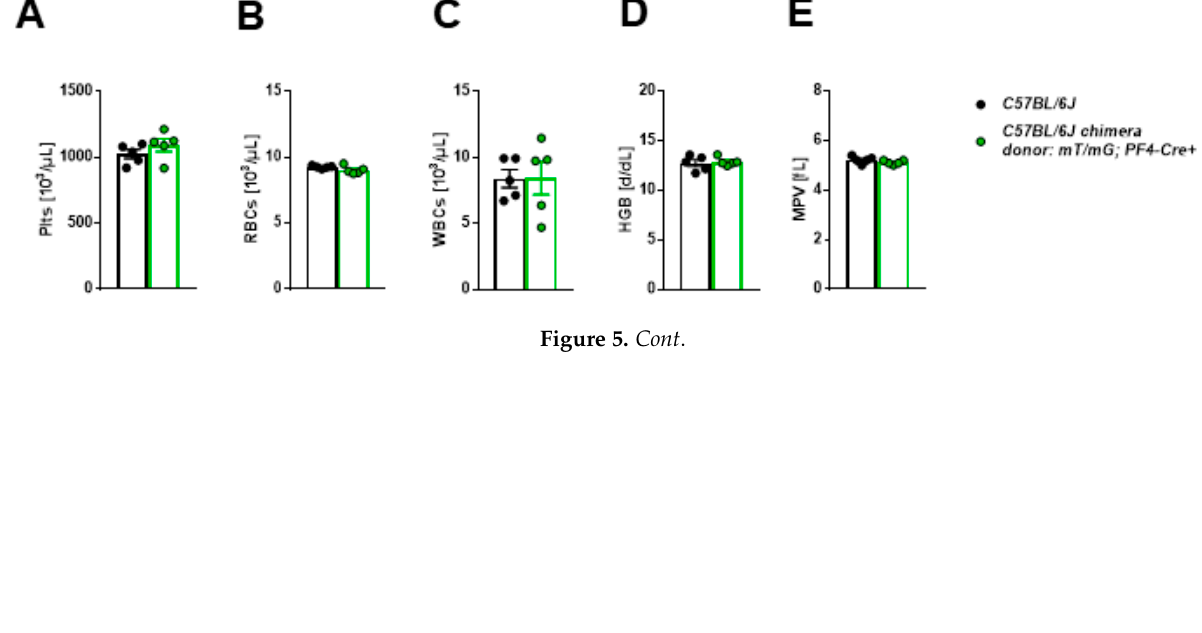
Figure 5. Transfer of bone marrow from mT/mG; PF4 ‐ Cre positive mice to C57BL/6 mice leads to the appearance of mG ‐ positive platelets in the circulation of chimeric mice. C57BL/6 mice were exposed to sublethal irradiation and received bone marrow cells of mT/mG;PF4 ‐ Cre positive mice. Platelet count ( A ), number of red blood cells ( B ) and leukocytes ( C ), hemoglobin concentration ( D ) and platelet size ( E , mean platelet volume) were determined in heparinized whole blood by a hematology analyzer (Sysmex, Norderstedt, Germany). No major differences between bone marrow chimeric mice and C57BL/6 controls could be detected, n = 5. ( F ) Platelets from bone marrow chimeric mice were analyzed regarding their mT and mG fluorescence in the SSC and FSC specific profile. Only platelets with mG fluorescence could be detected, n = 5. Statistical analysis was performed by two ‐ tailed Student ′ s t ‐ test . Bar graphs depict mean values ± SEM. Plts = plate ‐ lets.